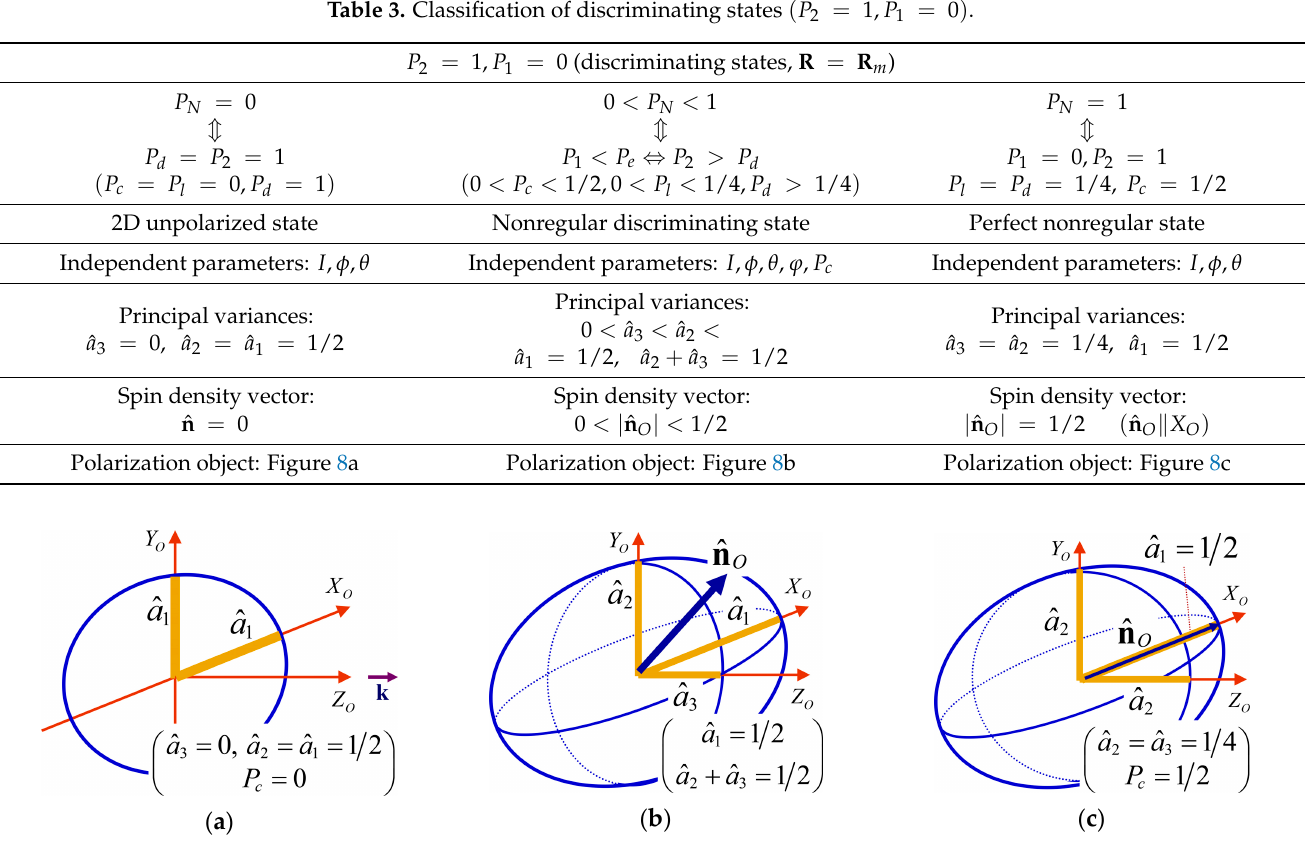
Figure 8. Polarization density object of a discriminating state R m ( P 1 = 0, P 2 = 1 ) : ( a ) zero spin corresponds uniquely to the regular case P c ( R m ) = 0 ⇔ R m = R u − 2 D ; ( b ) R m is nonregular if and only if P c ( R m ) > 0, and ( c ) R m is perfect nonregular if and only if P c ( R m ) =